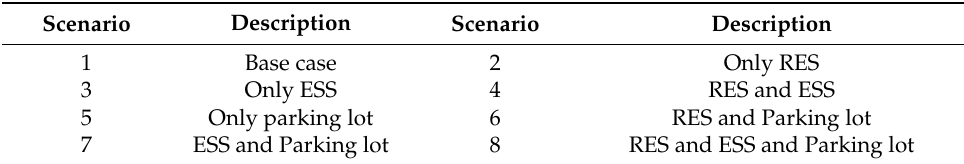
Figure 5. Single line diagram of the IEEE-33 bus network. Table 6. Description of the conducted